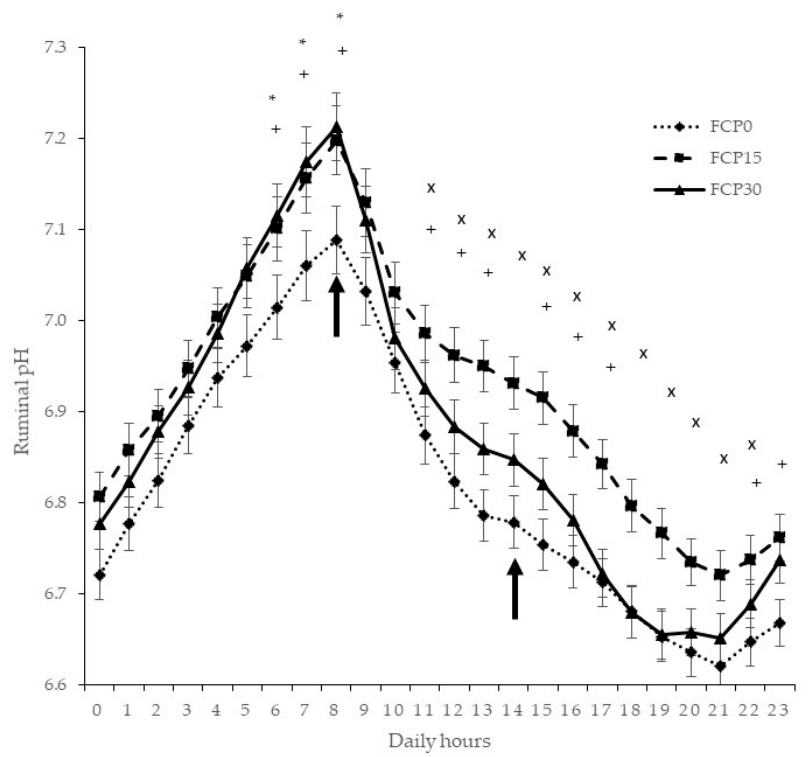
Figure 1. Least square means for hourly ruminal pH throughout the day by feeding treatment. Symbols indicate significant differences ( p < 0.05). *: a linear contrast, x: a quadratic contrast among treatments, +: contrasts between FCP0 and FCP15 + FCP30 treatments. Black arrows indicate the time of feeding.